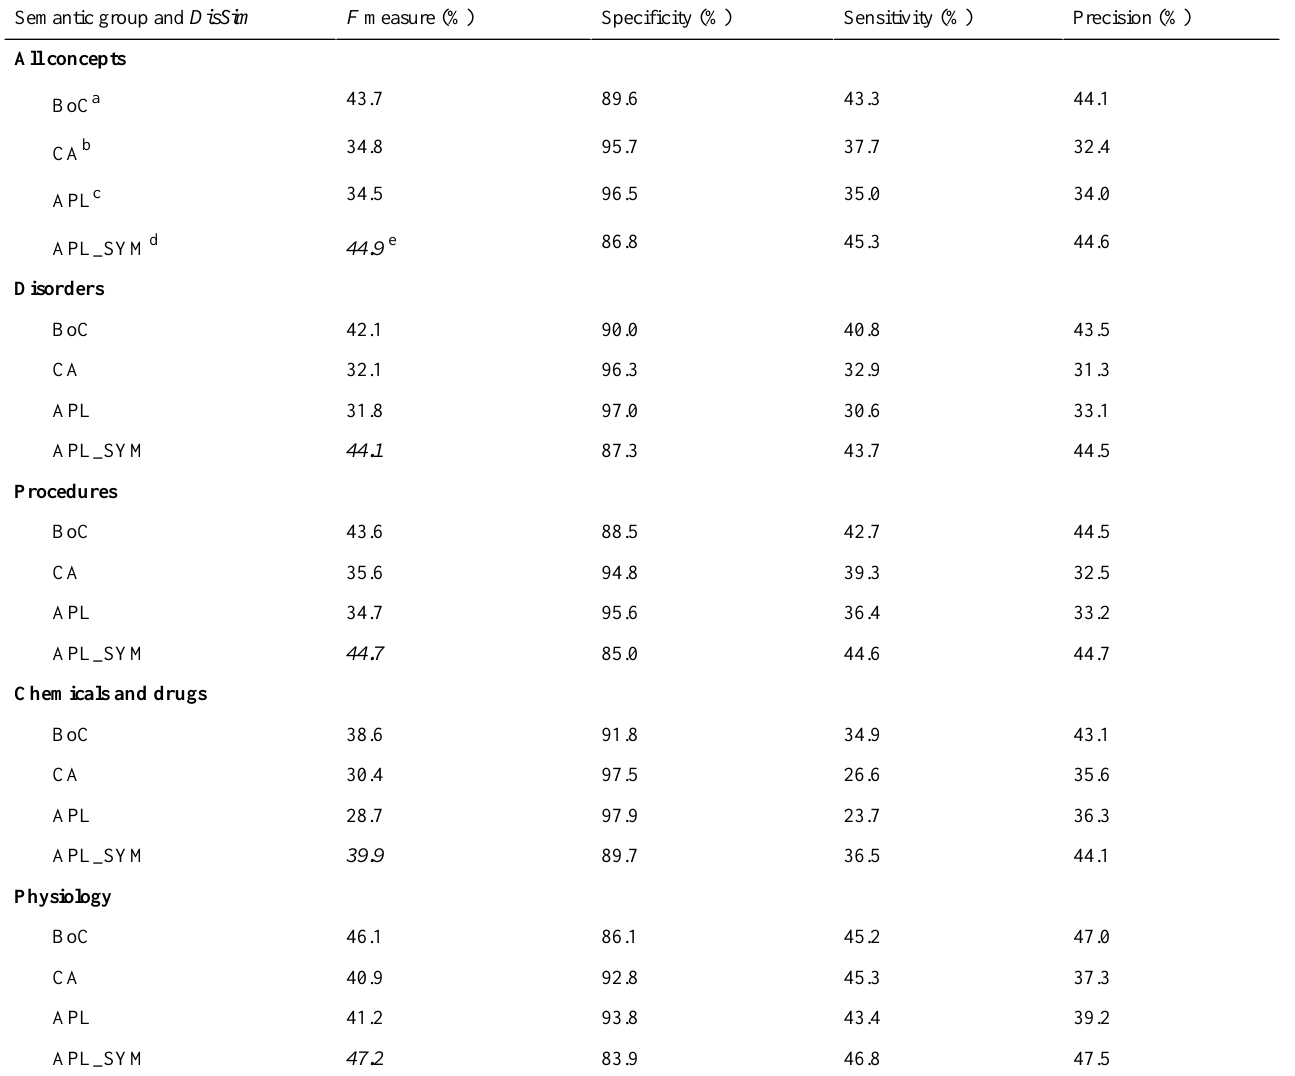
Table 3. The results for the testing data set separated by semantic group, using the parameters tuned on the training data set for fresh concepts